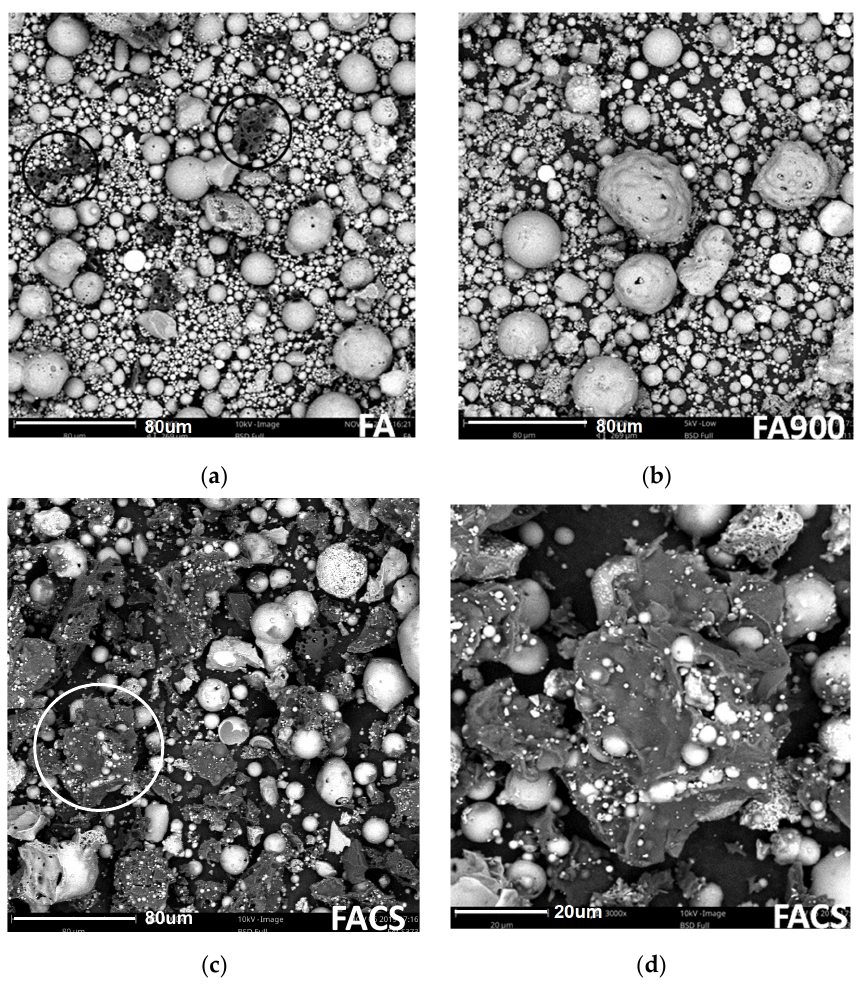
Figure 1. Selected SEM images of the studied adsorbents: ( a ) initial fly ash (FA) with encircled spongy structures (unburned coal?); ( b ) fly ash activated at T = 1173 K (FA900); ( c ) initial fly ash modified by chitosan (FACS); ( d ) magnification of the encircled fragment in the ( c )